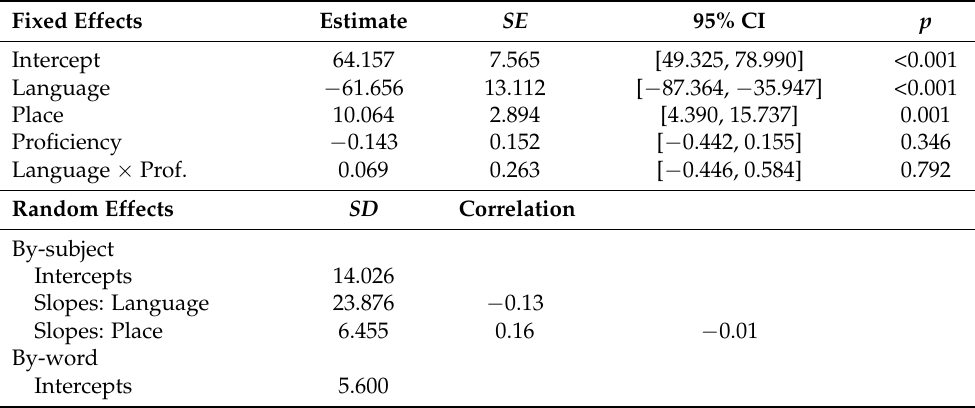
Table 4. Summary of linear mixed-effects model fit to the voiceless stop